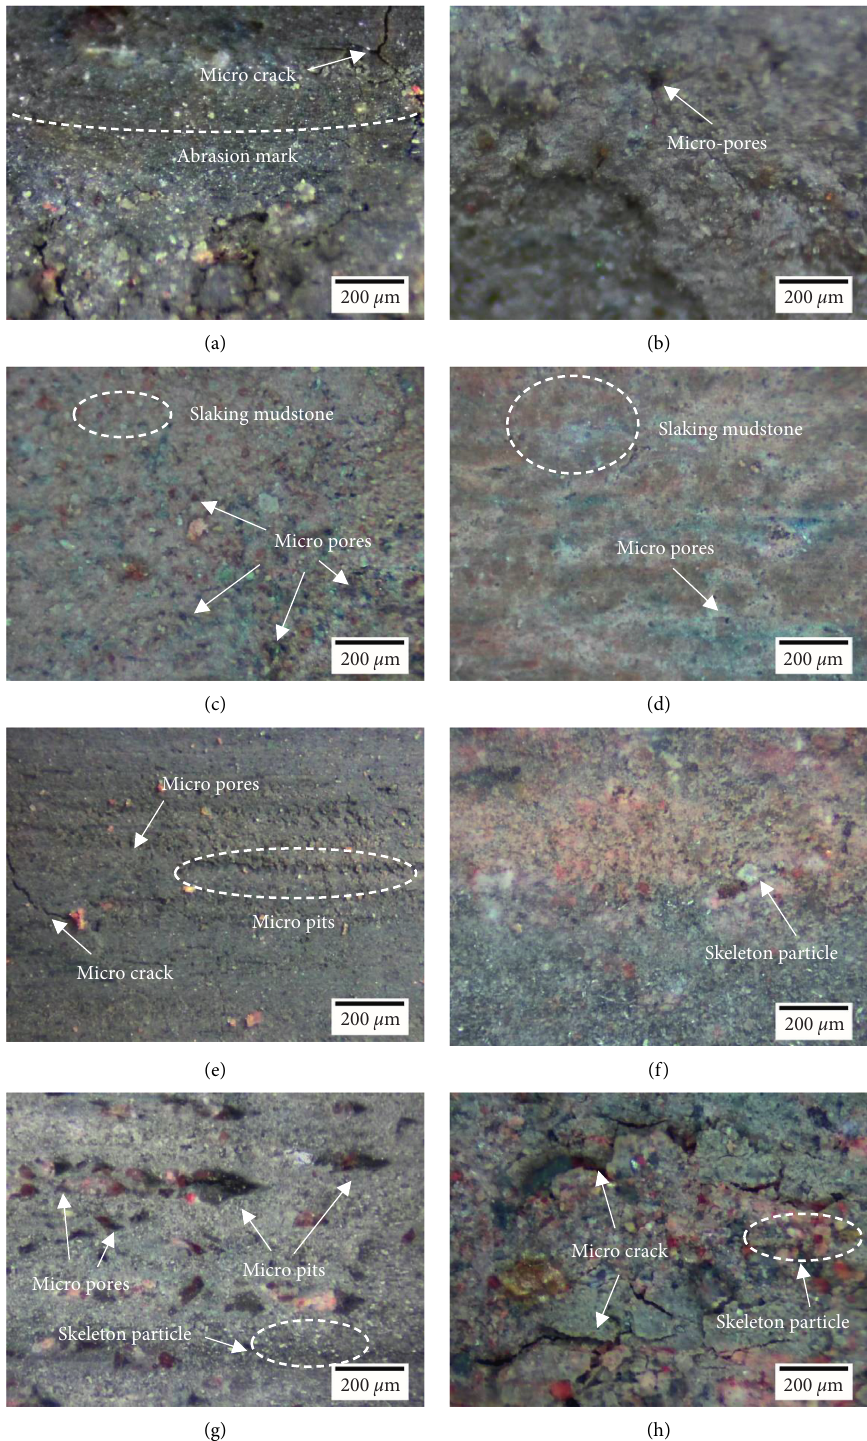
Figure 3: Evolution of microstructures of cutting grooves of rock blocks at × 400 magnification. (a) 5 min, P / D � 0.04; (b) 10min, P / D � 0.06; (c) 15min, P / D � 0.07; (d) 20min, P / D � 0.09; (e) 30min, P / D � 0.13; (f) 40 min, P / D � 0.15; (g) 50min, P / D � 0.17; (h) 60min, P / D �